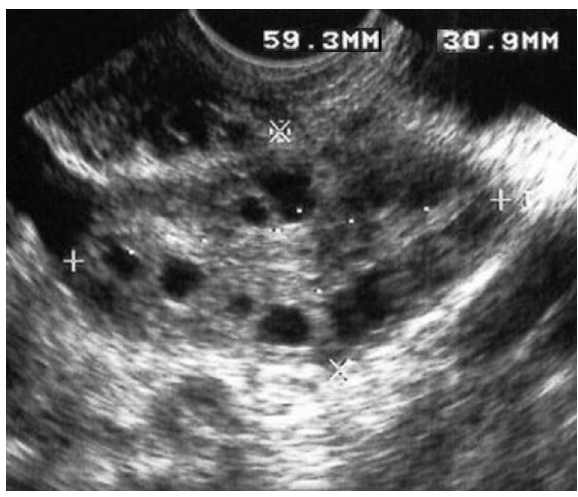
Figure 1: Transverse US image of the left ovary demonstrates the “ string of pearls ”